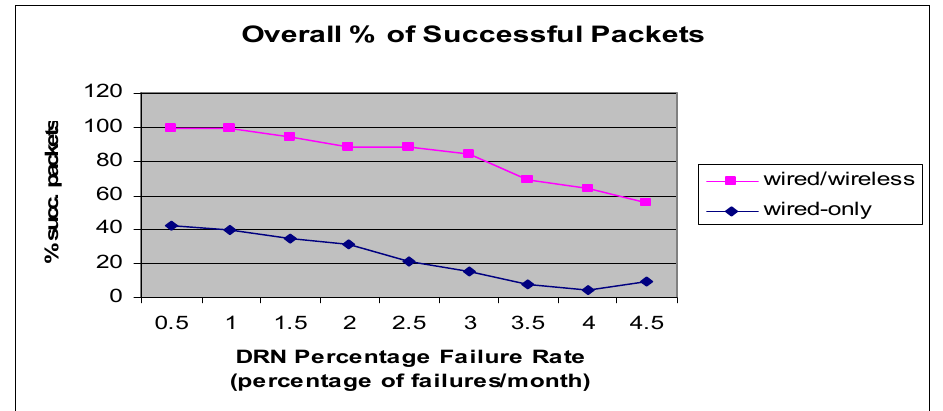
Figure 15. Simulation results for the integrated wired/RF wireless sensor